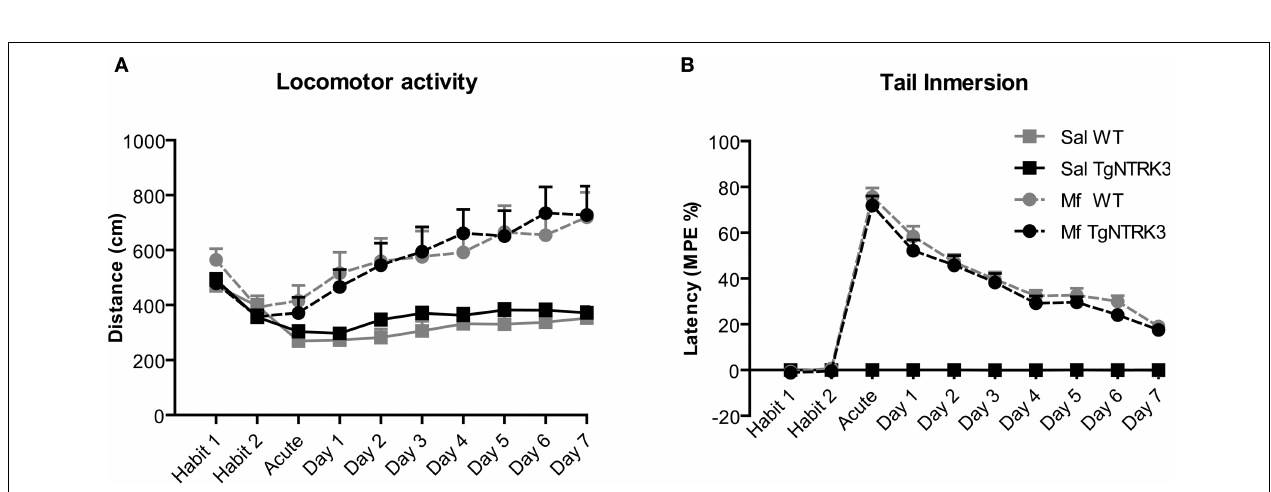
tail withdrawal latency is given. Antinociceptive effects were evaluated 30 min after morphine injection. Data are expressed as means ± SEM of the maximum possible effect (MPE %). * p < 0.05 (Student’s t test, WT vs. TgNTRK3 mice).